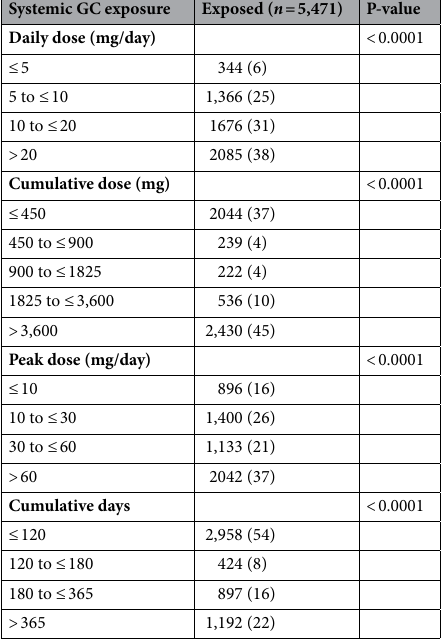
Table 2. Categorized glucocorticoid level of exposure variables among exposed patients during the study period. Values are presented as n (%). All glucocorticoid exposure variables were calculated with the equivalent dose (mg) according to the relative potency. The P-value calculated from the Chi-square test for goodness-of- fit is shown. GC